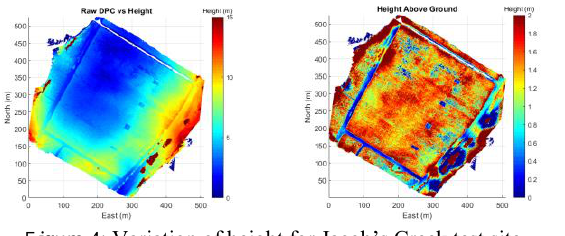
Figure 4: Variation of height for Jacob’s Creek test site (left) prior to removal of surface topography and (right) afterwards. Note change of scale for images After resampling back to original ground resolution using 2D spline interpolation, with Golay filtering (Chen et al., 2004) applied to reduce noise, the complex 3D reference ground plane is subtracted from the original DPC height data to normalise (‘flatten’) the point cloud (Figure 4